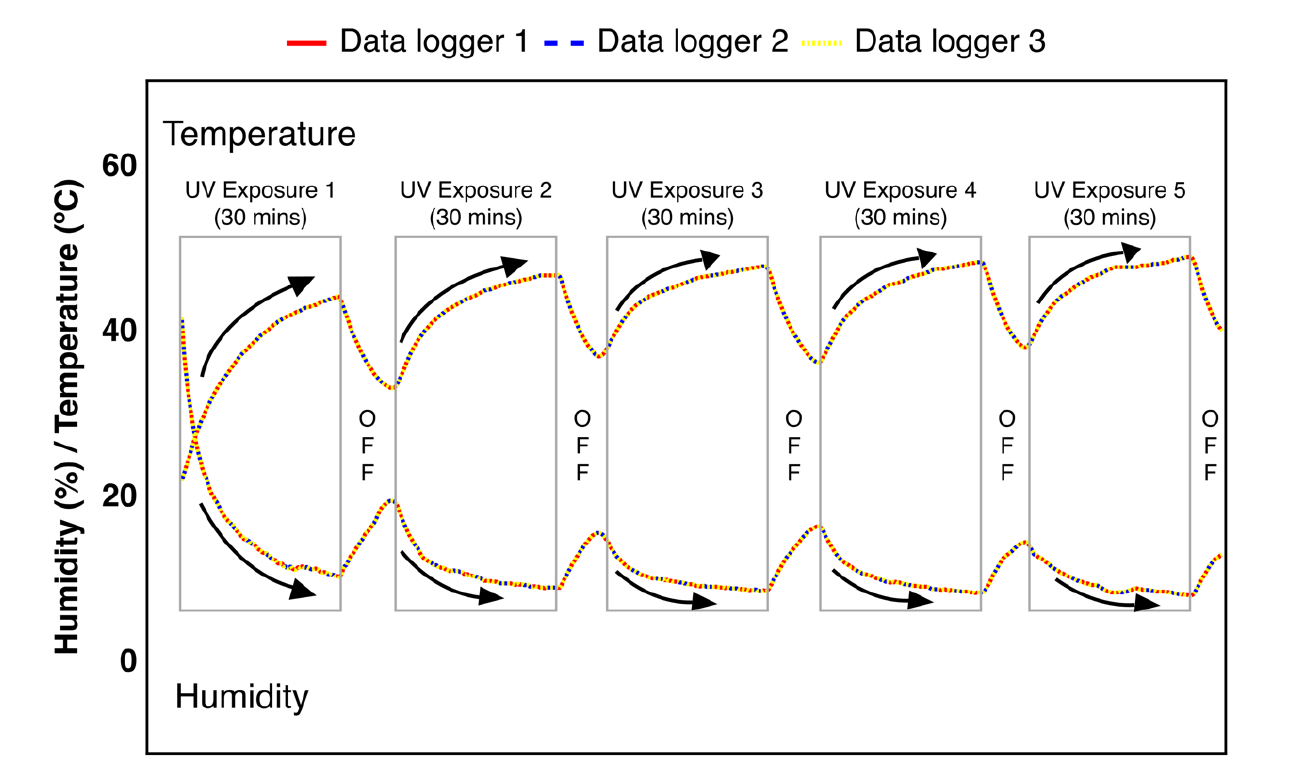
Figure 6. Continuous monitoring of the temperature and humidity during UV exposure recorded from three different dual data channel loggers. Each exposure was set to a power-on time of 30 min with a power-off interval of 5 min. The average maximum recorded temperature was 50 °C, and the average minimum recorded humidity was 8%.